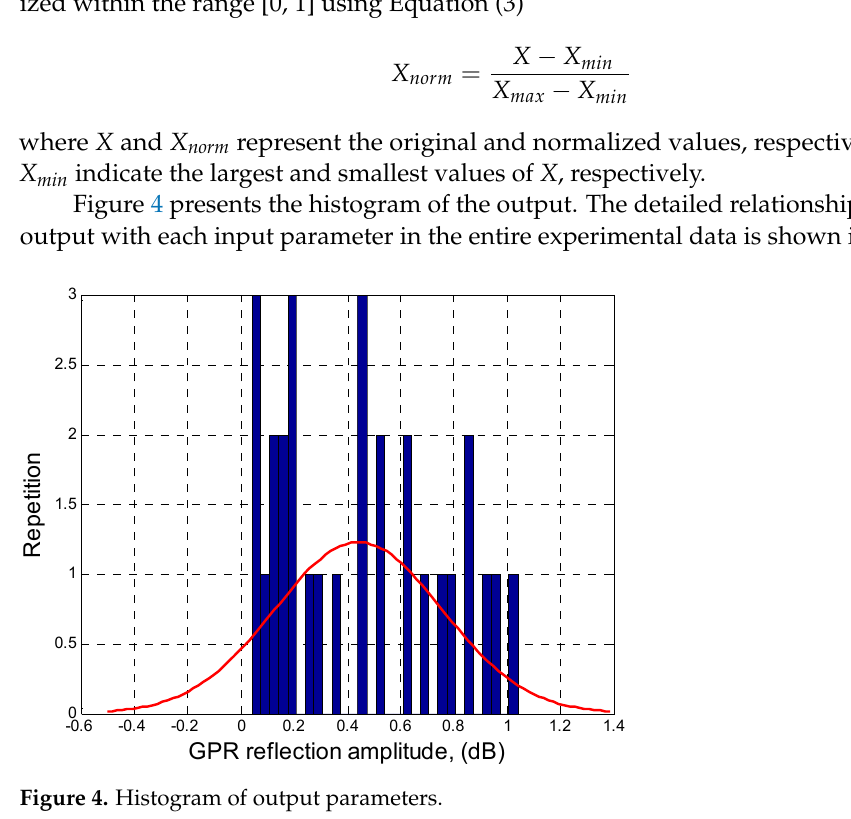
Figure 4. Histogram of output parameters.